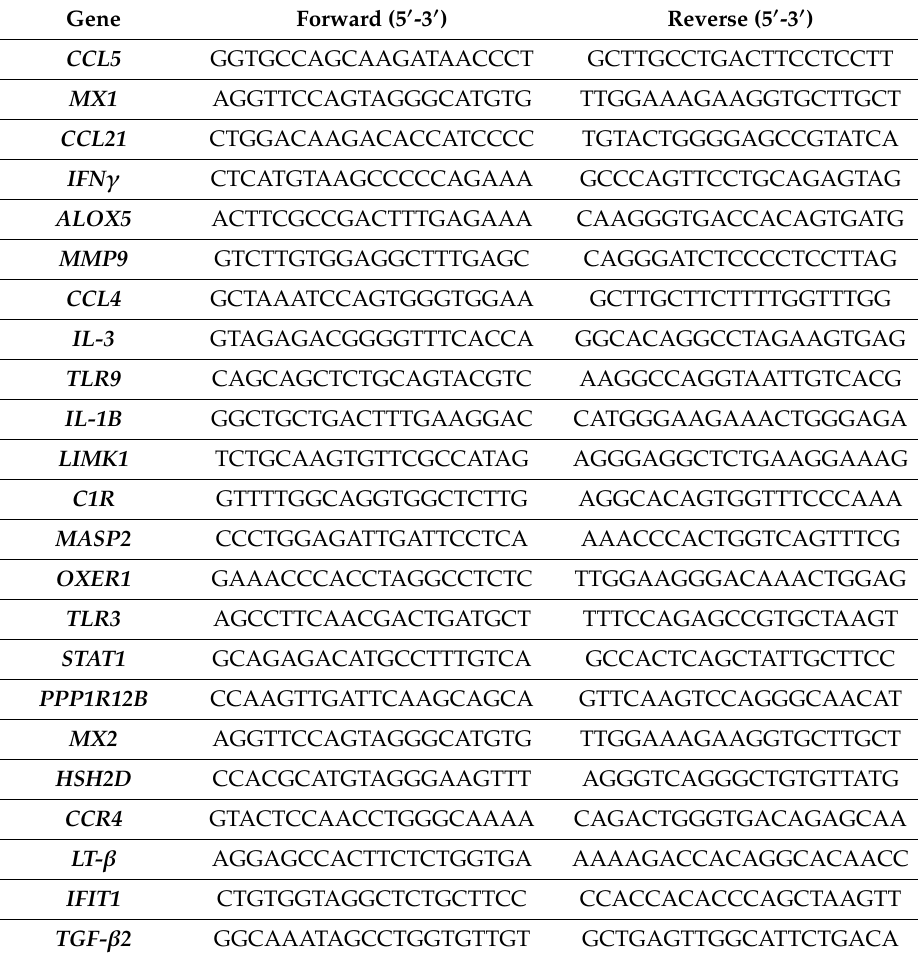
Table 1. List of primers sequences used for reverse transcriptase real-time PCR.